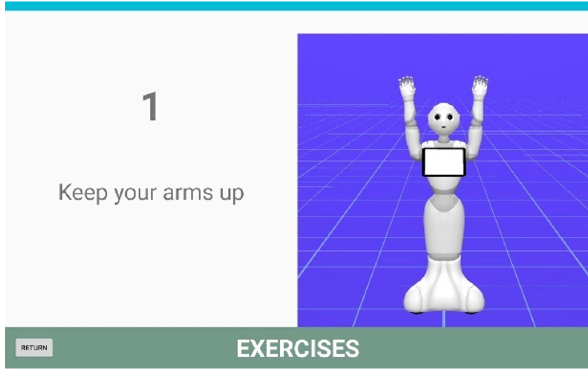
Figure 6. Example of shoulder